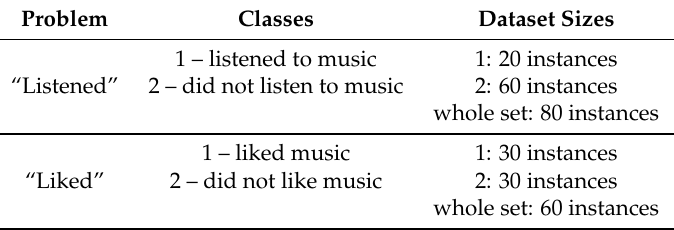
Table 6. Datasets generated from the vital sensing